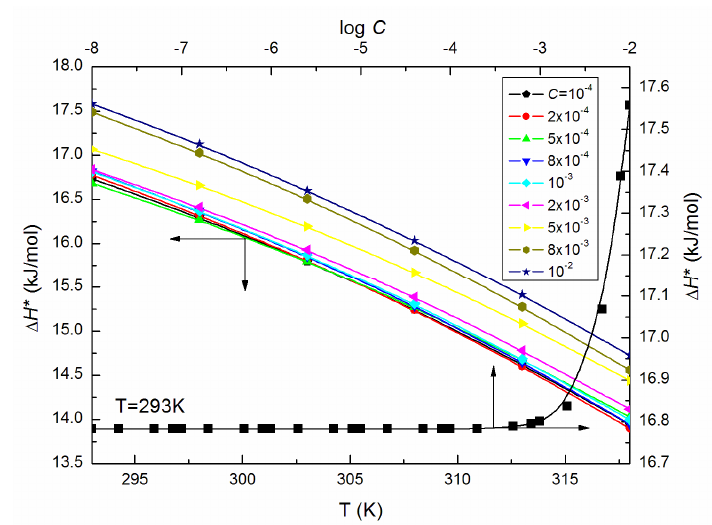
Figure 4. A plot of the values of shear activation energy ( C , as well as the values of the partial molar volume ( temperature, T.